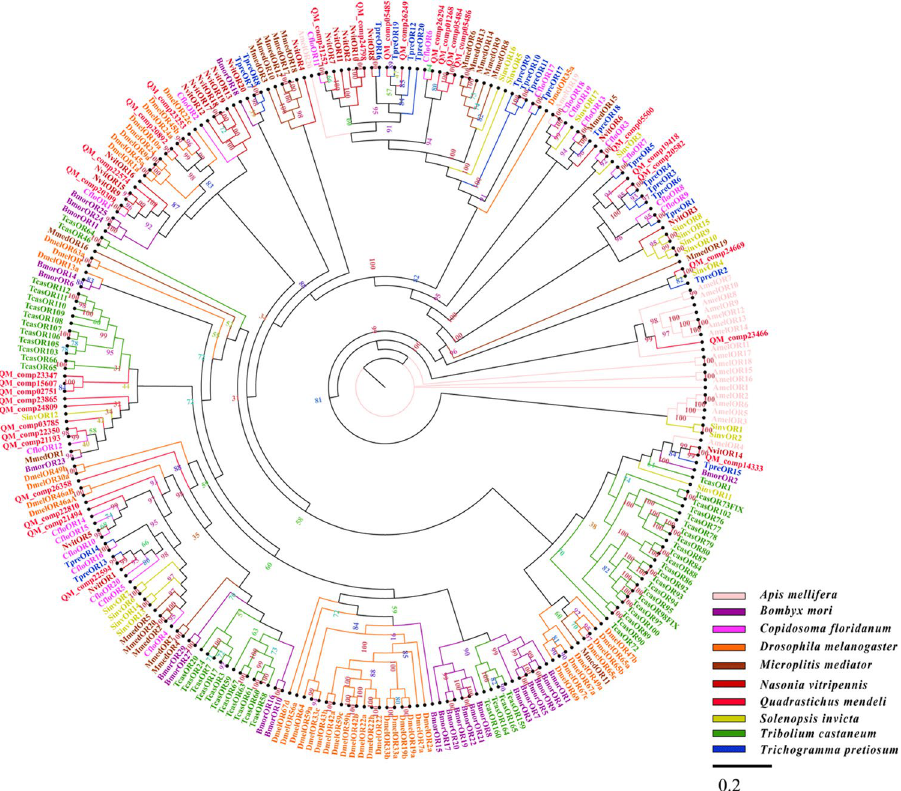
Figure 6. Phylogenetic tree of odorant receptors (ORs) from Quadrastichus mendeli and other insects based on the maximum likelihood method. Included are ORs from Apis mellifera (Amel), Bombyx mori (Bmor), Copidosoma floridanum (Cflo), Drosophila melanogaster (Dmel), Microplitis mediator (Mmed), Nasonia vitripennis (Nvit), Quadrastichus mendeli (Qmen), Tribolium castaneum (Tcas), and Trichogramma pretiosum (Tpre). The specific clades are marked. Node support was assessed with 1000 bootstrap